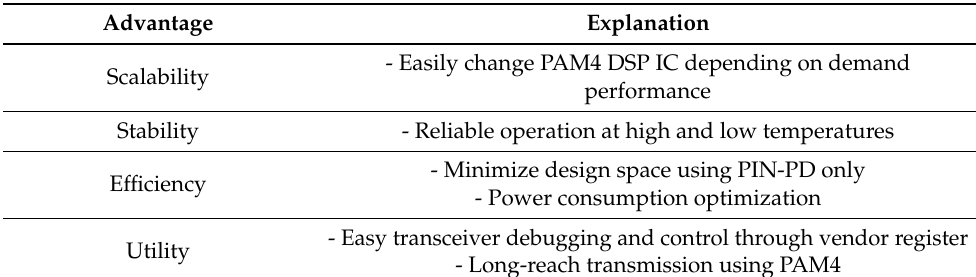
Table 5. Advantages of the proposed